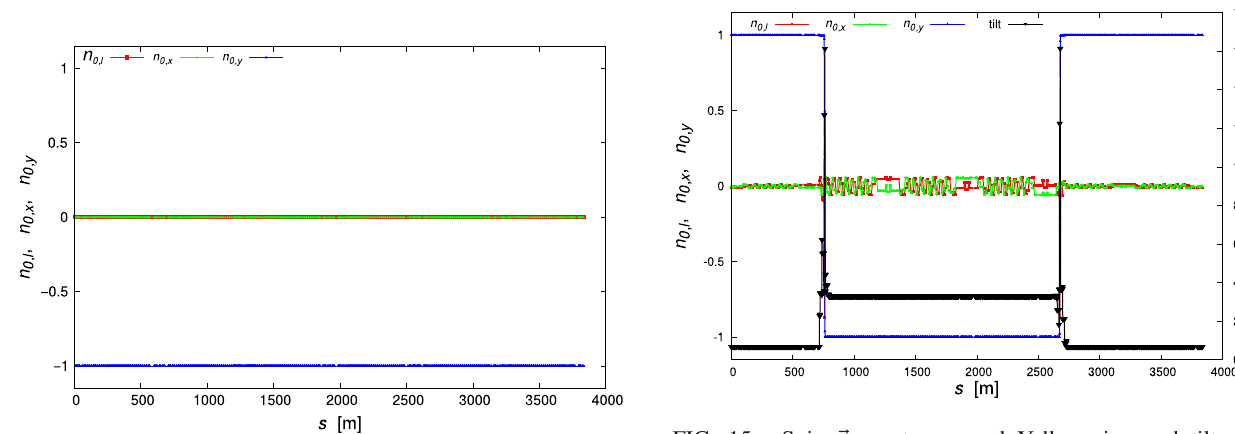
FIG. 12. Local horizontal (red) and vertical (blue) closed orbit bumps in the 3 o ’ clock snake region of the RHIC ring, using OPERA field maps. The 9 o ’ clock bump is similar, with reversed signs.